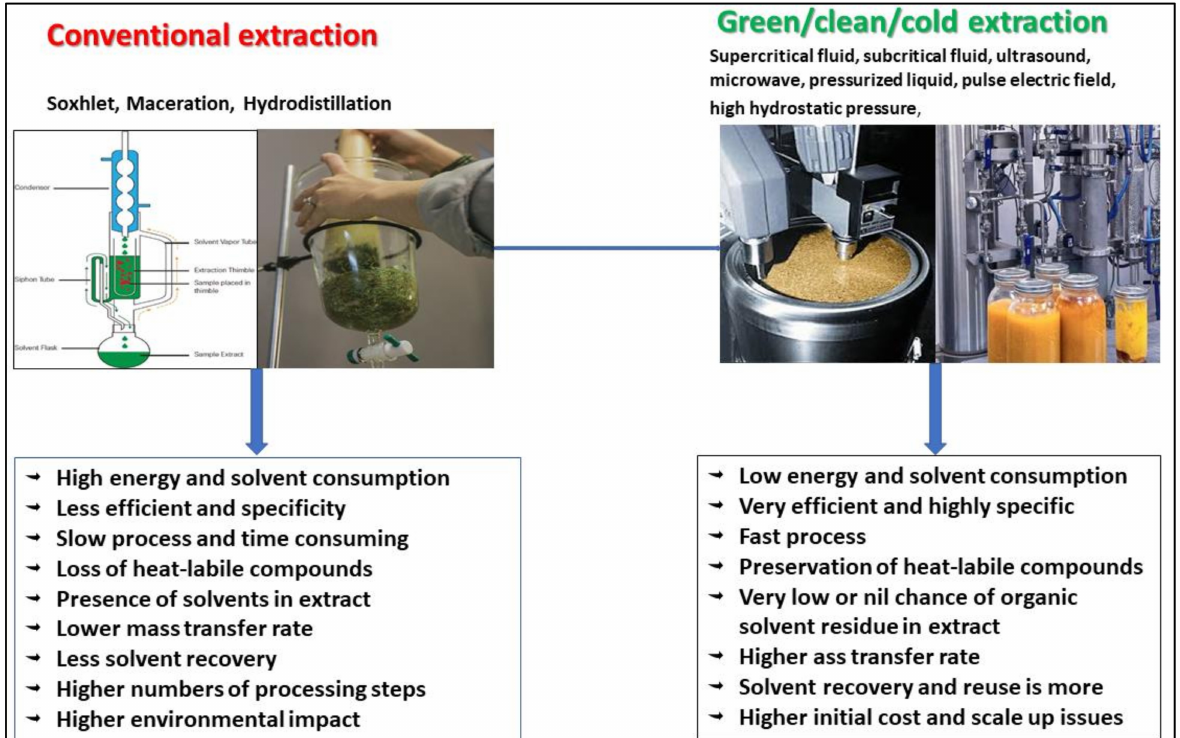
Figure 3. Comparative analysis of conventional and green extraction